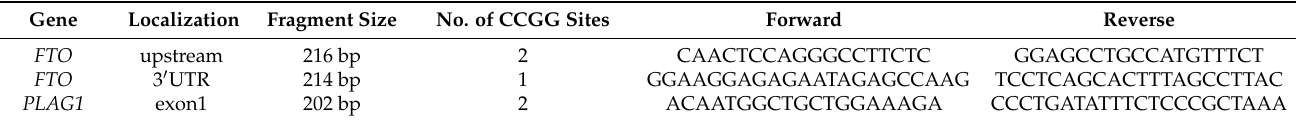
Table 1. Sequences of primers used for qPCR